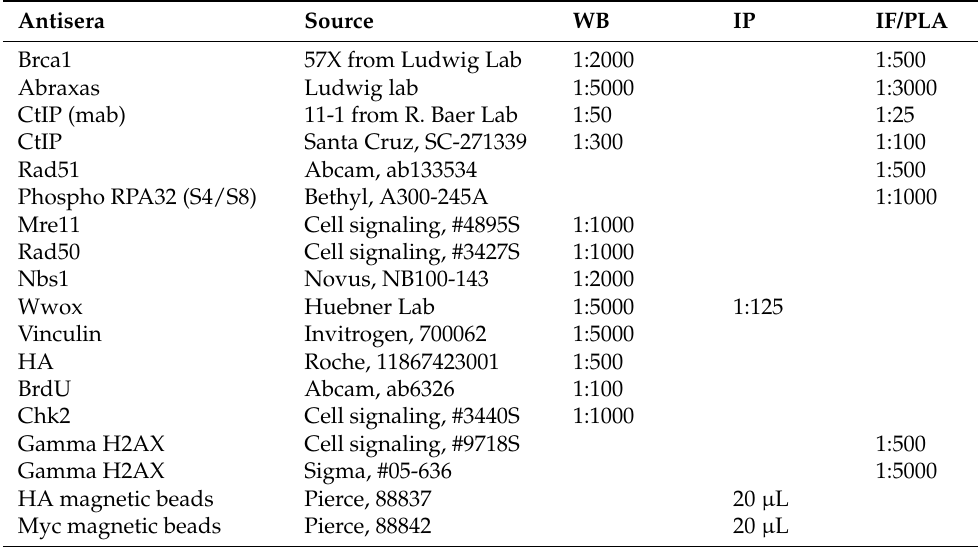
Table 1. Antisera